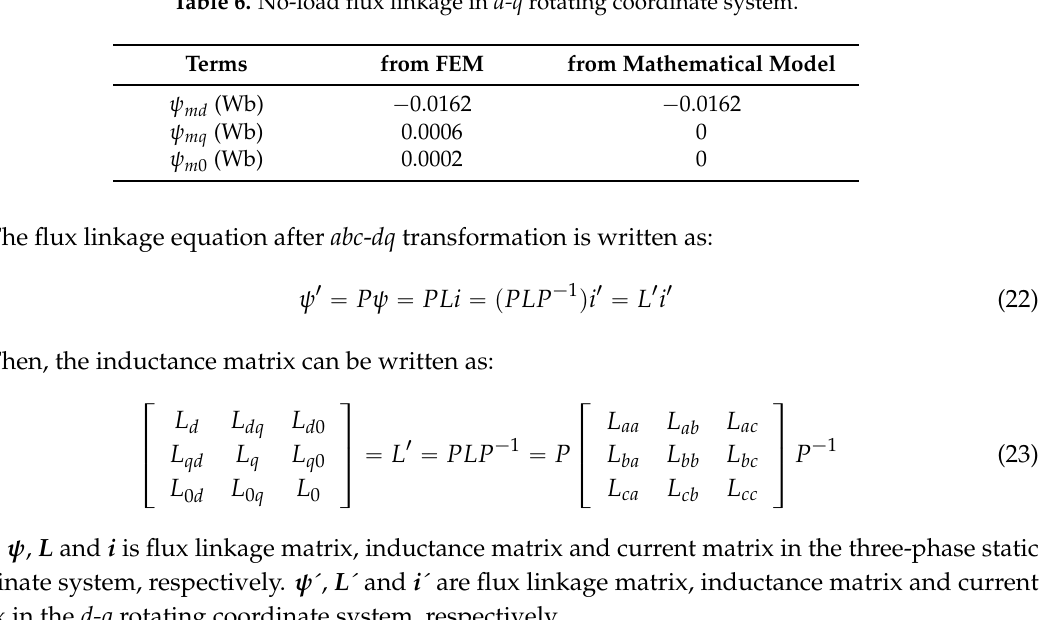
Table 6. No-load flux linkage in d-q rotating coordinate system.